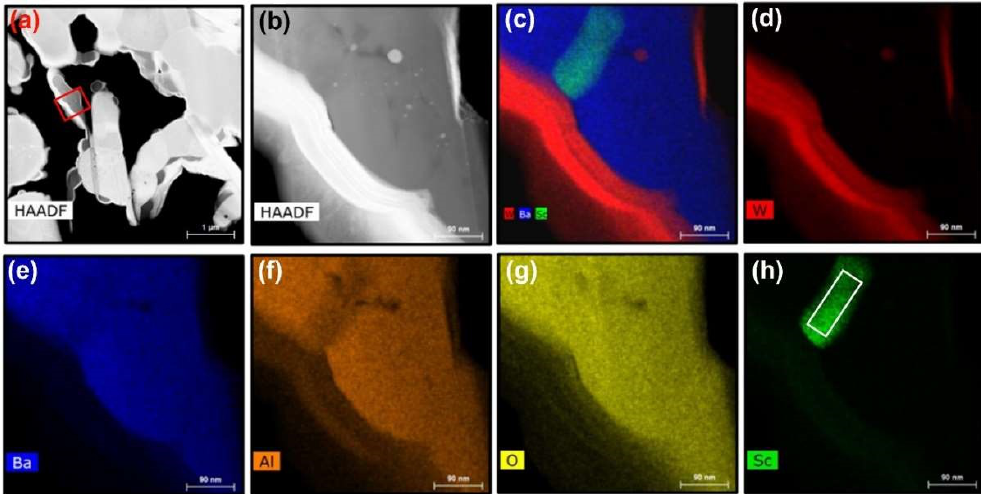
Figure 4. EDS elemental analysis of a Ba-Al oxide particle that also exhibits an encased Sc signal. ( a ) Low-magnification HAADF image of near-surface region of the cathode sample; ( b ) high- magnification HAADF image showing the area scanned for EDS mapping, which corresponds to the red box in image ( a ); ( c) composite elemental map showing distributions of W, Ba and Sc; ( d – h ) individual elemental maps of W, Ba, Al, O and Sc, where the red box in ( h ) outlines the region of EDS quantitative measurement.